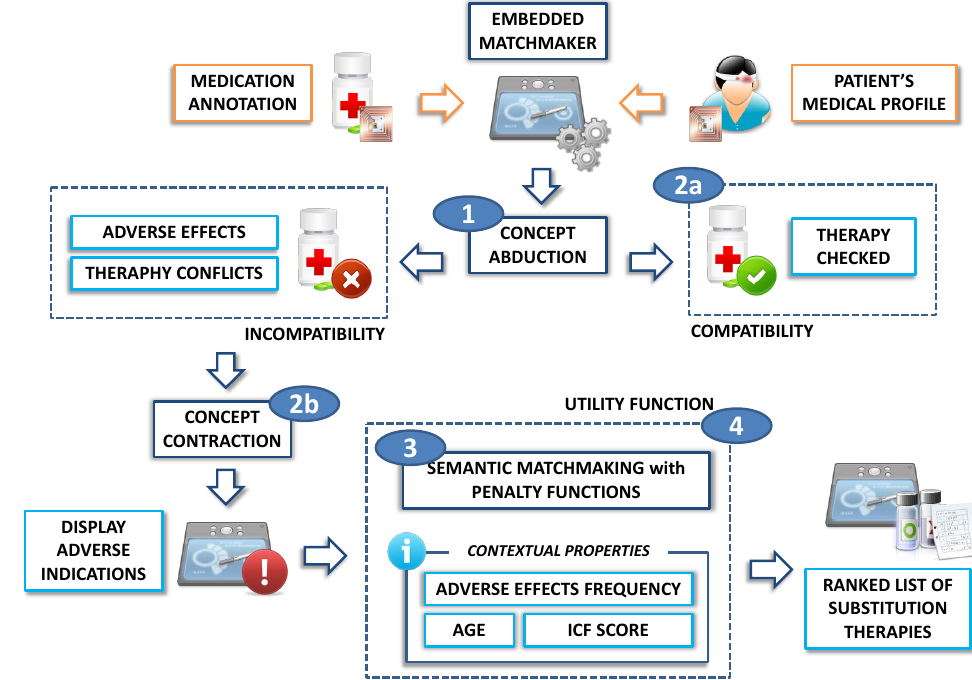
Figure 7. Reference framework for therapy